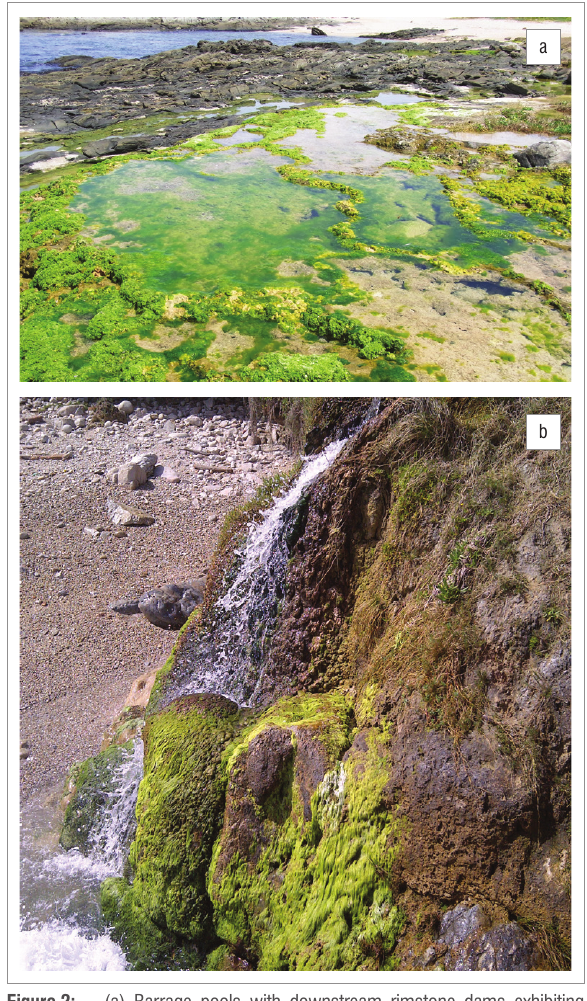
Figure 2: (a) Barrage pools with downstream rimstone dams exhibiting extensive chlorophitic growth at the marine interface at Schoenmakerskop on 15 October 2013 (photo: Lynette Clennell) and (b) waterfall deposits formed from a pump house outflow at Rebelsrus on 17 October 2013 (photo: Thomas G.